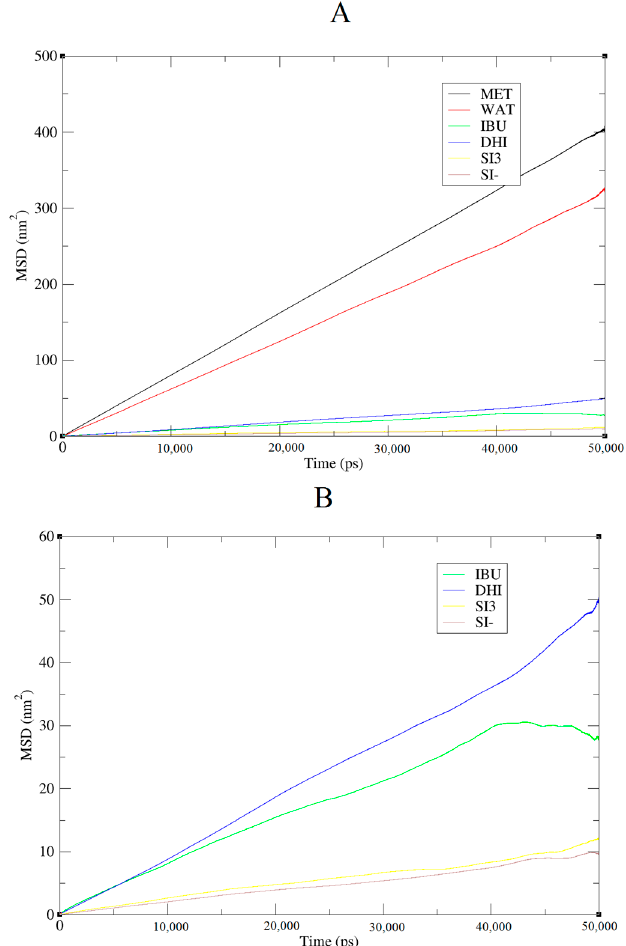
Figure 5. MSD of the molecular species during the simulation. ( A ) MSD of all the compounds present in the mixture; ( B ) MSD of IBU, DHI, SI3 and SI − .